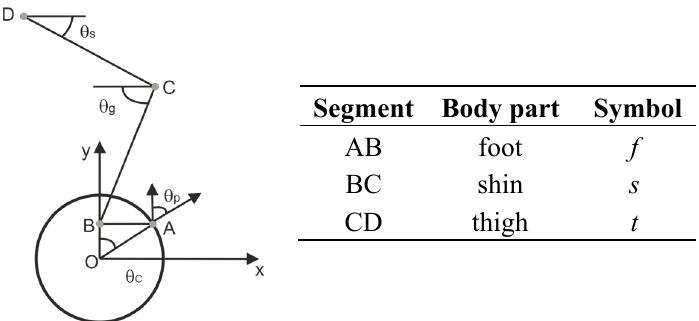
Figure 2. Kinematic chain of lower limb and angle between body